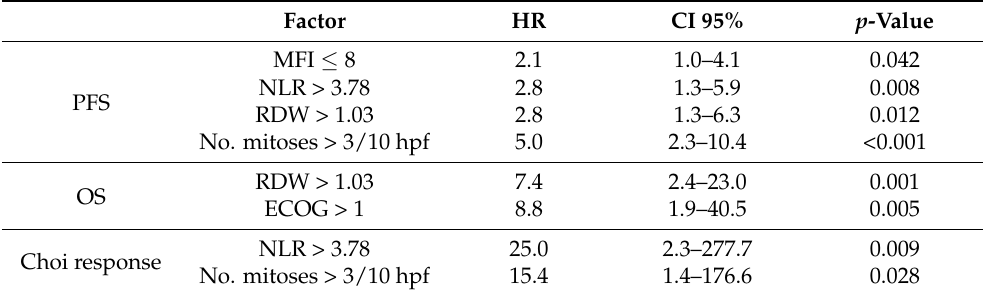
Table 3. Multivariate analysis of clinicopathological factors according to progression-free survival (PFS), overall survival (OS), and Choi response.